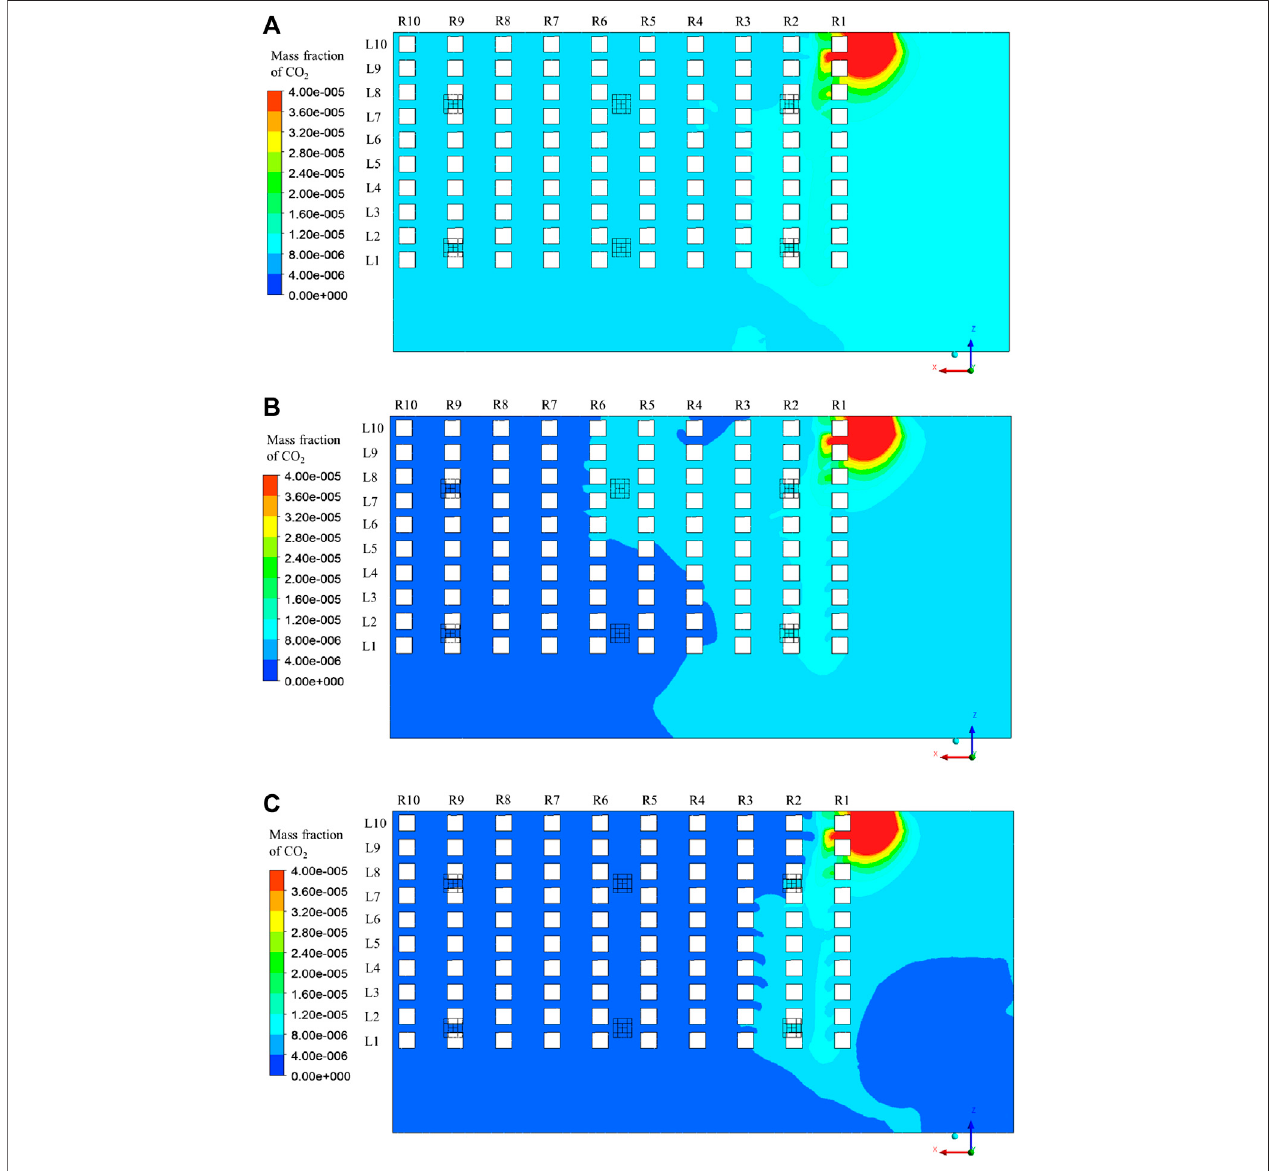
FIGURE 6 | Distribution of mass fraction of CO 2 in Plane 3: (A) Case 1; (B) Case 2; (C) Case 3.